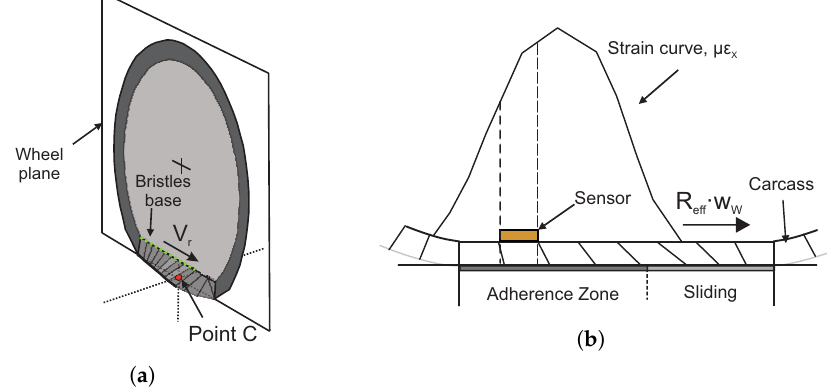
Figure 9. Hyphoteses of the strain measurement. ( a ) Example of the velocity in the base point of the bristle; ( b ) Ilustrations of the strain measurement for a tire bristles in the adhesion